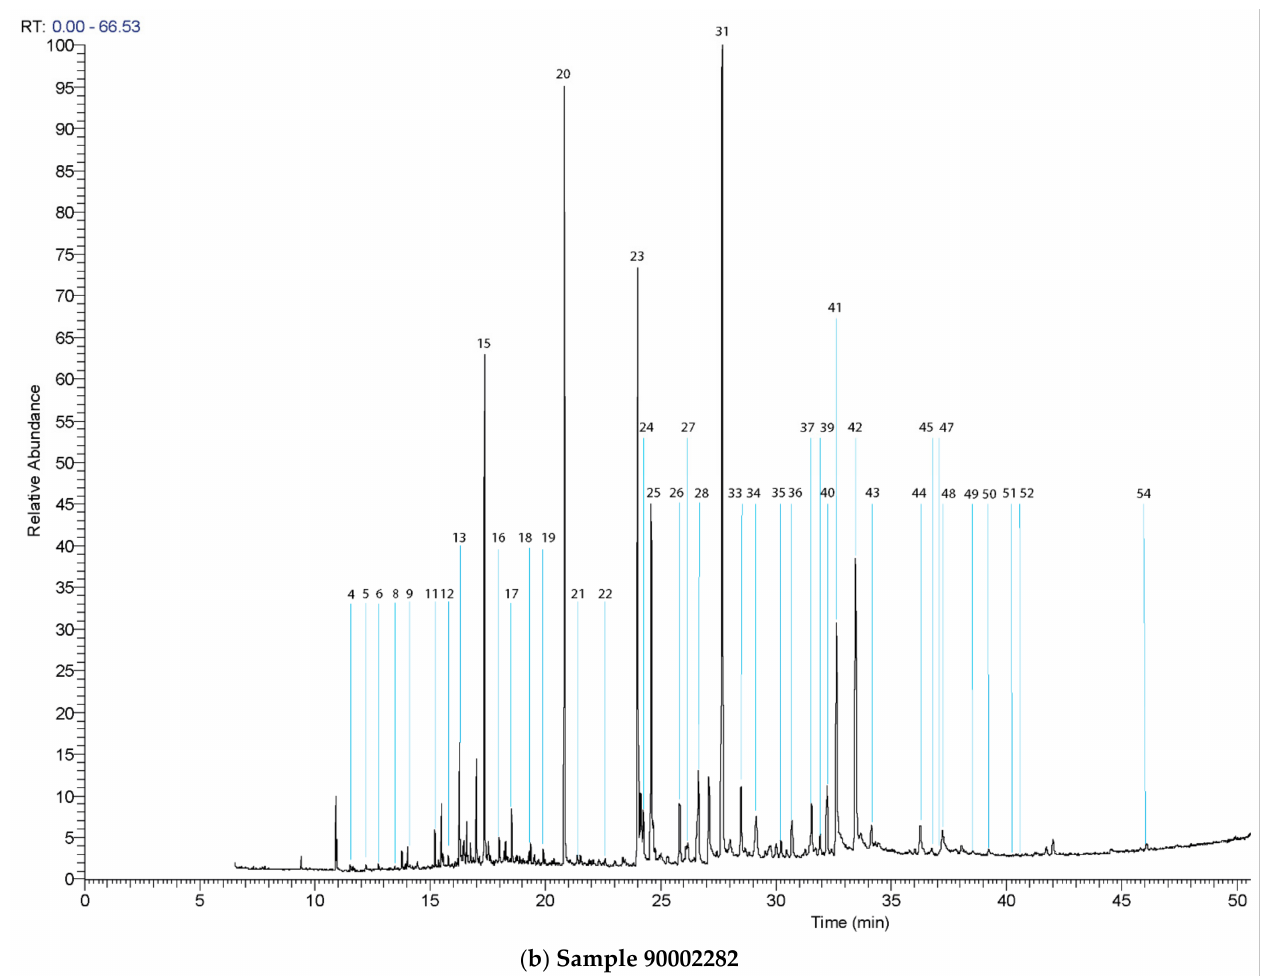
Figure 2. Partial total ion current chromatograms of samples 90001291 ( a ) and 90002282 ( b ). All of the compounds were identified as their TMS